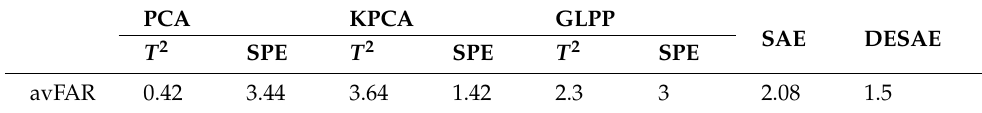
Table 3. AvFAR of PCA, KPCA, GLPP, SAE and DESAE on TE